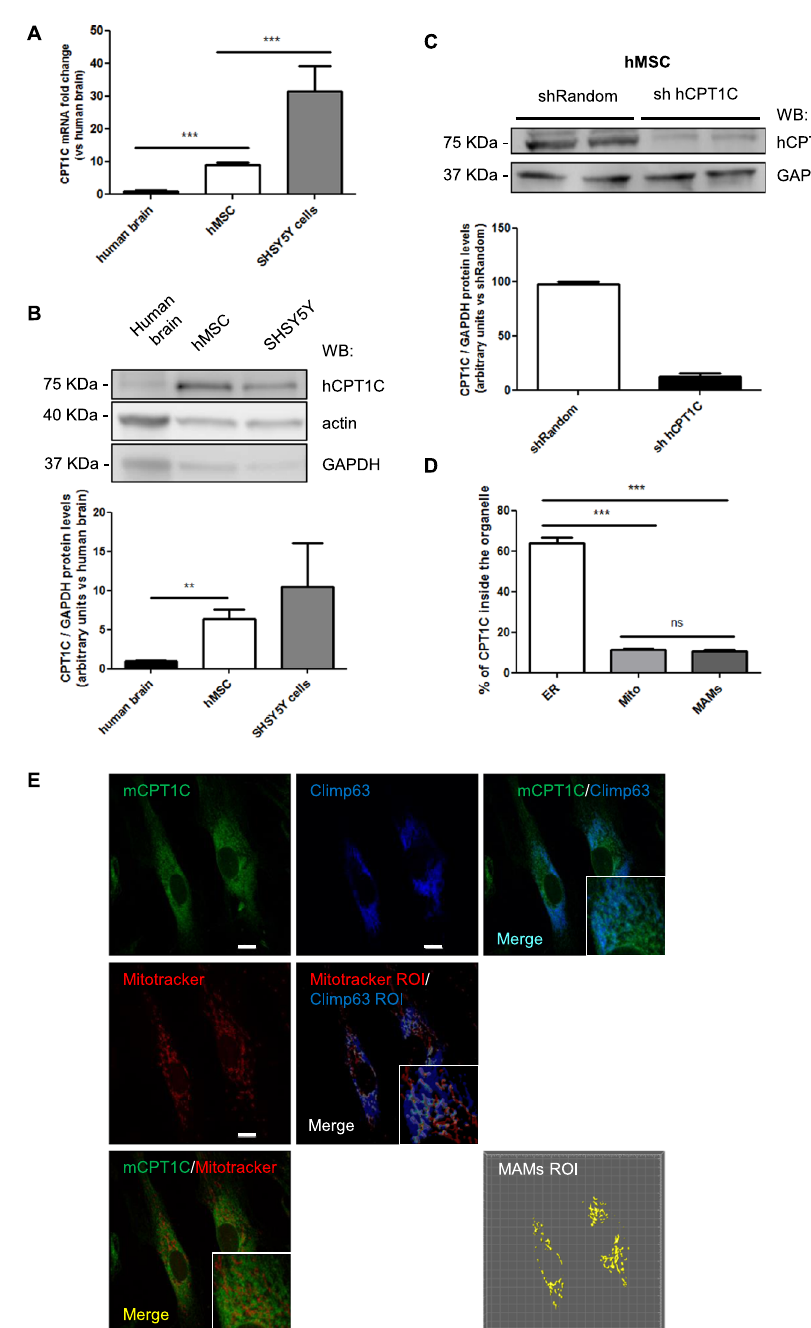
Figure 1. CPT1C is expressed in adult hMSCs. ( A ) CPT1C mRNA levels were determined by real-time PCR in human brain, hMSCs and SH-SY5H cell line. Actin was used as a housekeeping gene. Results are shown as mean ± SEM of sextuplet. ( B ) Endogenous CPT1C was analyzed by Western Blot in hMSCs, human brain cells, and the SH-SY5Y human neuroblastoma cell line. GAPDH was used as a loading control. n = 3–6. ( C ) hMSCs were infected with a lentivirus expressing a random sequence (Random) or a silencing sequence for human CPT1C (sh hCPT1C). Transduced cells were selected by FACS. Expression of CPT1C analyzed by Western blot showed an 80% of reduction in silenced cells (sh hCPT1C). GAPDH was used as a loading control. Graph shows the mean ± SEM of 3 independent experiments performed in duplicate. ( D , E ) hMSCs were infected with a lentivirus to drive the expression of mouse CPT1C (pWPI-mCPT1C-IRES-GFP). Mitotracker Orange was used to stain mitochondria, while mCPT1C and Climp63, the latter used as an ER marker, were detected by immunocytochemistry. EV-hMSCs were used as a negative control for CPT1C immunocytochemistry (see the images in Supplemental Fig. 2).The graph shows the percentage of CPT1C inside the ER, in the mitochondria, or on the surface (region of interest, ROI) defined by the colocalization of the ER with the mitochondria (MAMs). Values shown in D are expressed as mean ± SEM of 3 independent experiments performed in duplicate (10 randomly selected cells per coverslips were analyzed). Scale bar 10 µ m. * p < 0.05; *** p <